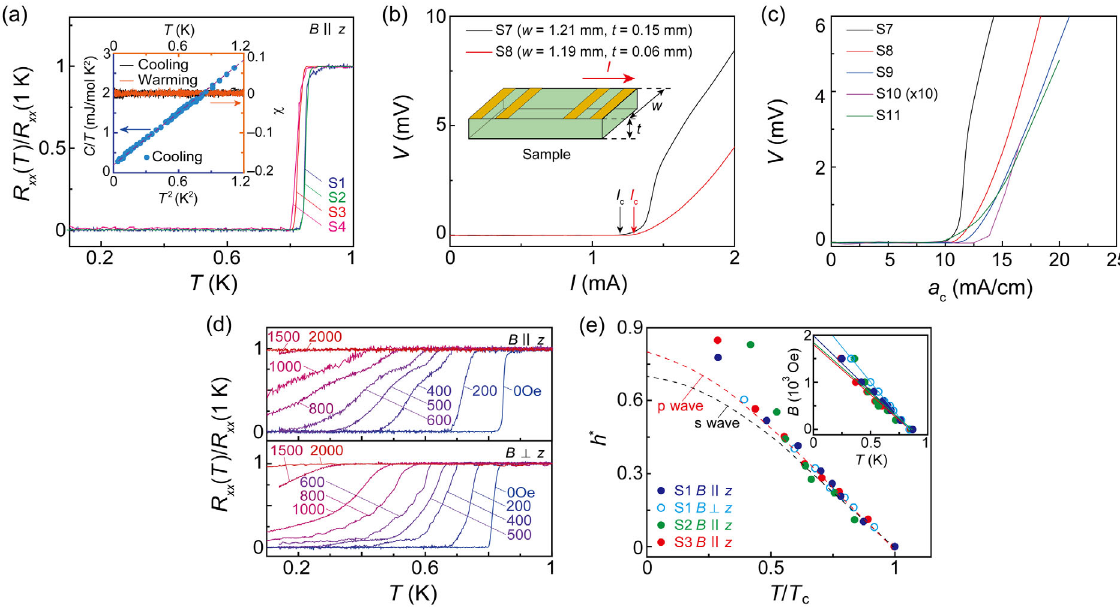
FIG. 5. Surface superconductivity of KZnBi. (a) T dependence of the normalized resistance in single-crystal samples (S1 − S4) (Fig. S7 [20]). The inset shows the heat capacity (blue dots), C=T , versus T 2 (left and bottom scales) which can be fitted to a linear function (purple dashed line) and the real part of the ac magnetic susceptibility with decreasing (black solid line) and increasing (orange solid line) T (right and top scales), measured with the single-crystal samples S5 and S6, respectively (see also Fig. S8 [20]). (b) Characteristic current ( I ) − voltage ( V ) curves of two samples with similar widths ( w ) and different thicknesses ( t ) (S7 and S8) at T ¼ 0 . 1 – 0 . 2 K. I is indicated by the red and blue arrows for S7 and S8, respectively. S7 is 2.5 times thicker than S8. (c) Critical current c ¼ I =w ) for S7 – S11 samples. The deviation in a density per unit width ( a is smaller than that of the critical current density per unit c c c ¼ I =wt ) (Fig. S9 [20]). (d) T dependence of the normalized resistance in S1 under B field parallel (top) and perpendicular area ( j c c (bottom) to the z -direction (for S2 and S3, see Fig. S7 [20]). The measurement geometries are illustrated in Fig. S7(g) [20]. (e) T=T c dependence of reduced critical field ( h (cid:1) ) in samples S1 – S3 for B parallel (solid dots) and perpendicular (open dots) to the z direction (Appendix). Red and black dashed lines are the WHH curve of p -wave and s -wave superconductors, respectively. Inset of (e) shows the linear T dependence of H for samples S1 − c 2